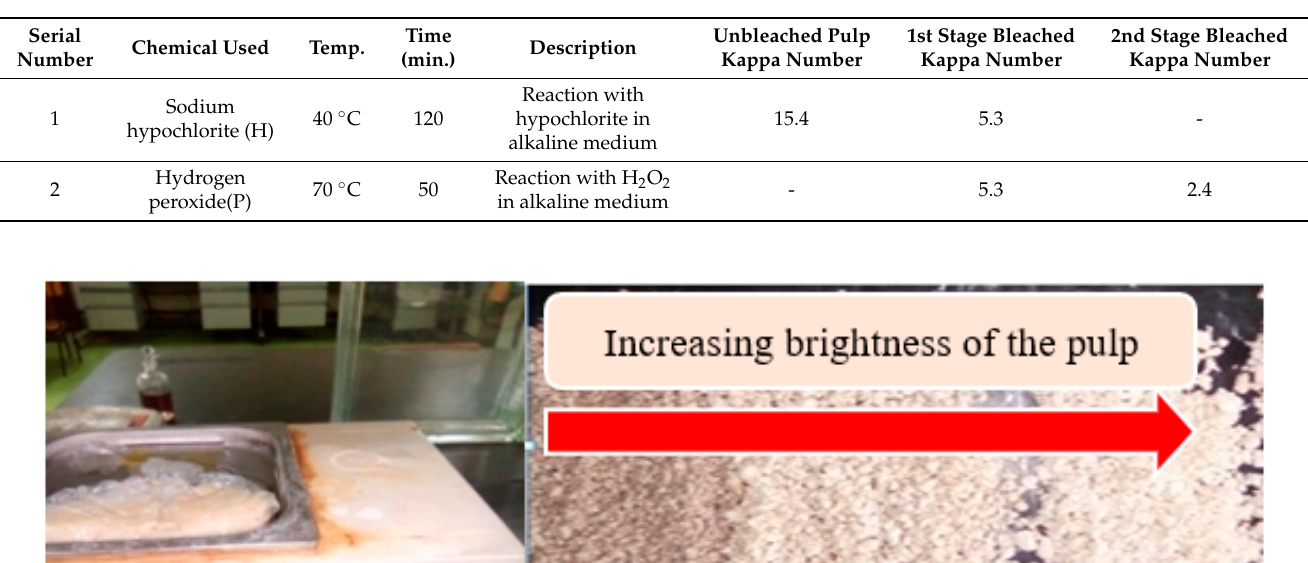
Table 6. Physical strength of M. azedarach sheets blended with waste cotton.